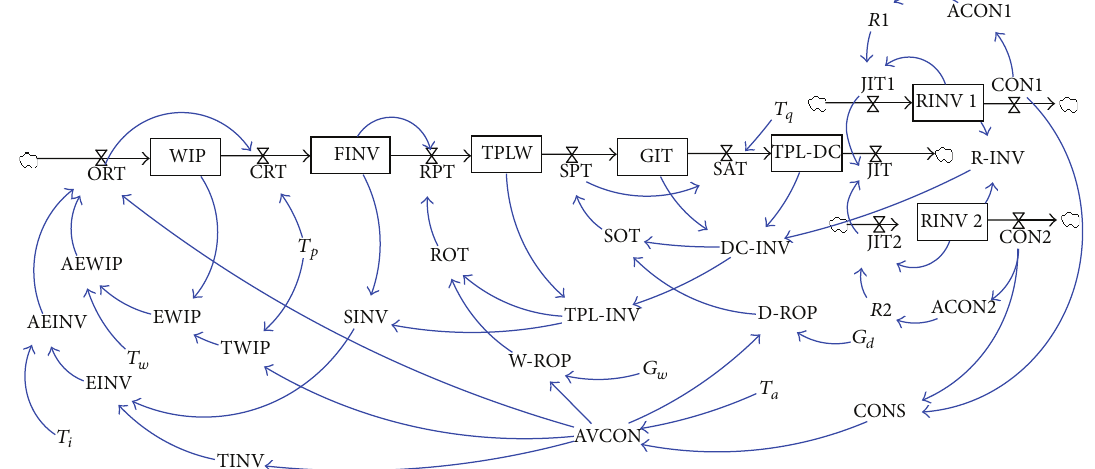
Figure 13: VMI&TPL-APIOBPCS model causality diagram.